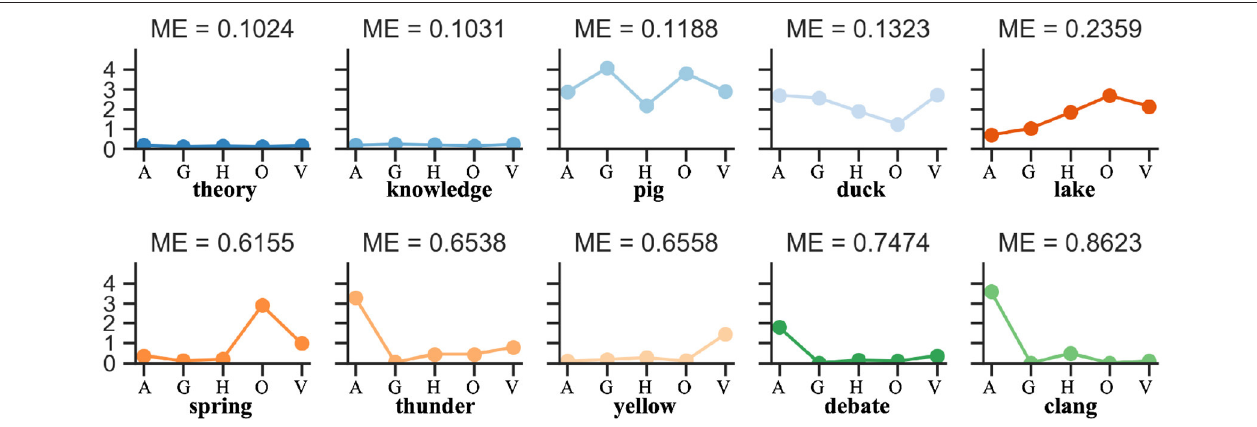
FIGURE 3 | Modality exclusivity demonstration. Modality exclusivity (ME) is a metric measuring how much of a concept is perceived through a single perceptual modality. For each concept, the value of ME is calculated as the perceptual strength range divided by the sum, and spanning from 0 to 100% for completely multimodal to completely unimodal